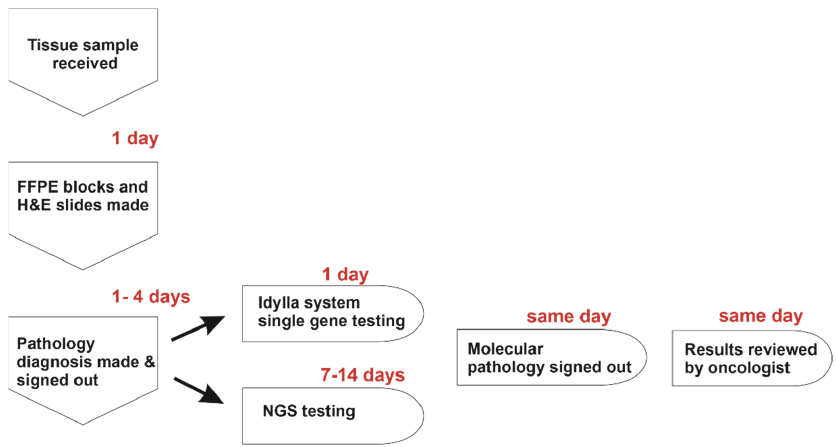
Figure 3. Algorithm for processing of tumor samples for molecular testing .